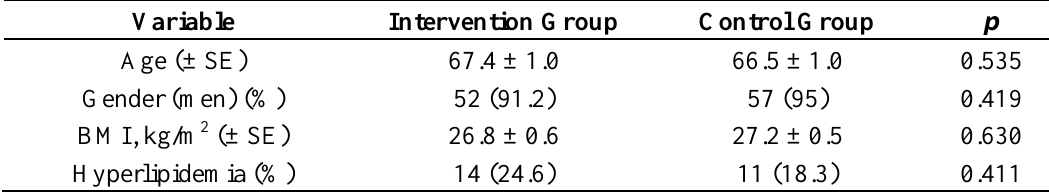
Table 1. Clinical characteristics of the intervention (n = 57) and control groups (n =